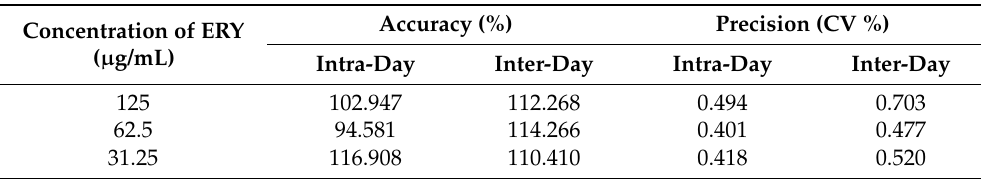
Table 3. The intra- and inter-day accuracy and precision for the microbial assay method measuring three different inhibitory concentrations of erythromycin against M. luteus